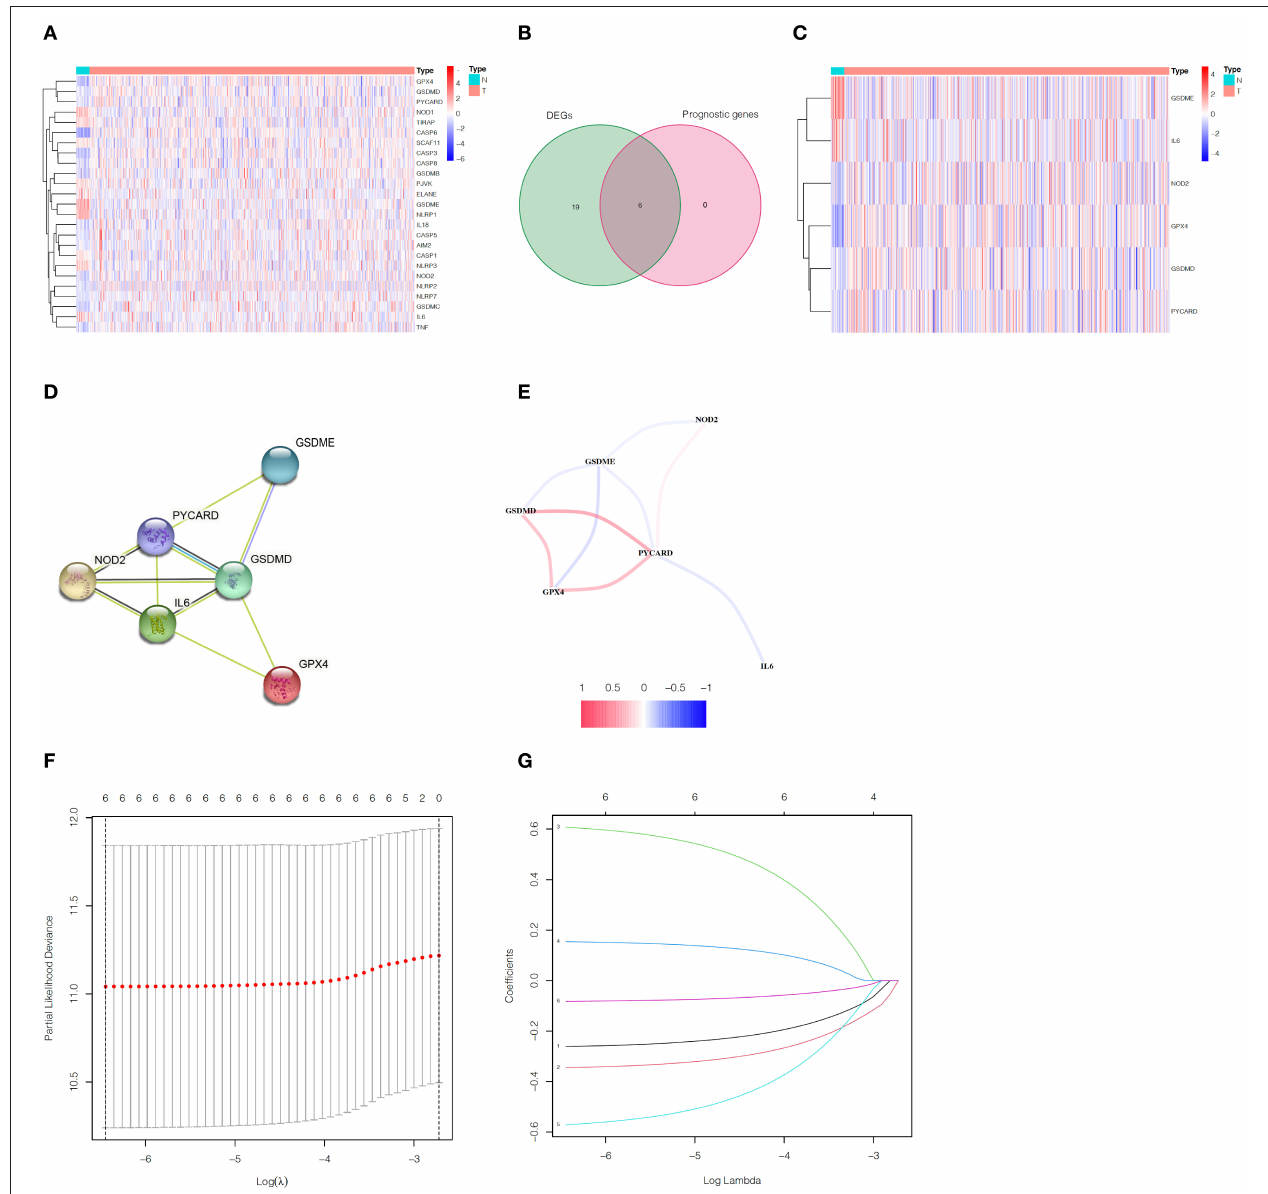
FIGURE 2 | Identification of pyroptosis-related prognostic DEGs in EC and construction of the gene signature. (A) The heatmap of 25 pyroptosis-related DEGs. (B) Venn diagram between pyroptosis-related DEGs and prognostic genes. (C) The heatmap of six pyroptosis-related prognostic DEGs. (D) The PPI network of pyroptosis-related prognostic DEGs. (E) The correlation network between pyroptosis-related prognostic DEGs. (F) The minimum criteria and (G) coefficients were calculated by LASSO Cox regression analysis to construct the gene signature.